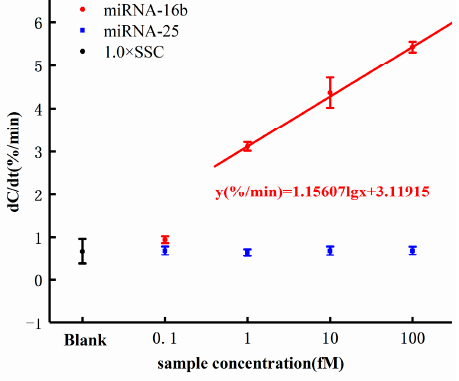
Figure 7. Capacitance change rates in response to different concentrations of miRNA ‐ 16b and miRNA ‐ 25 concentrations. miRNA-25